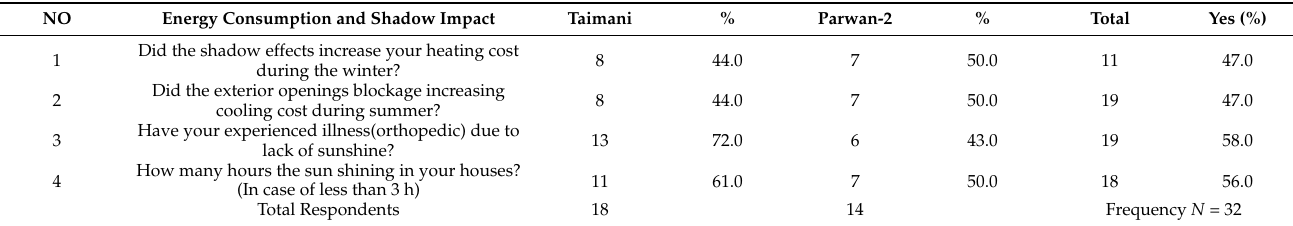
Table 4. Status of Energy Consumption and Shadow Impact.